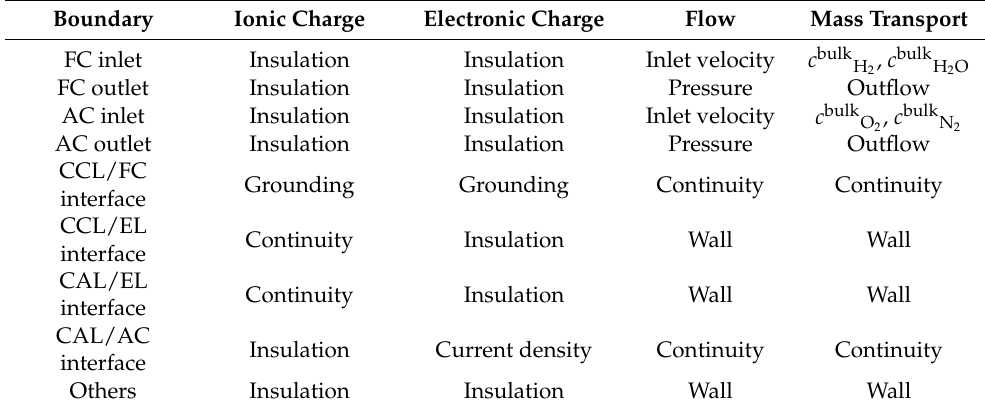
Table 5. Boundary conditions.